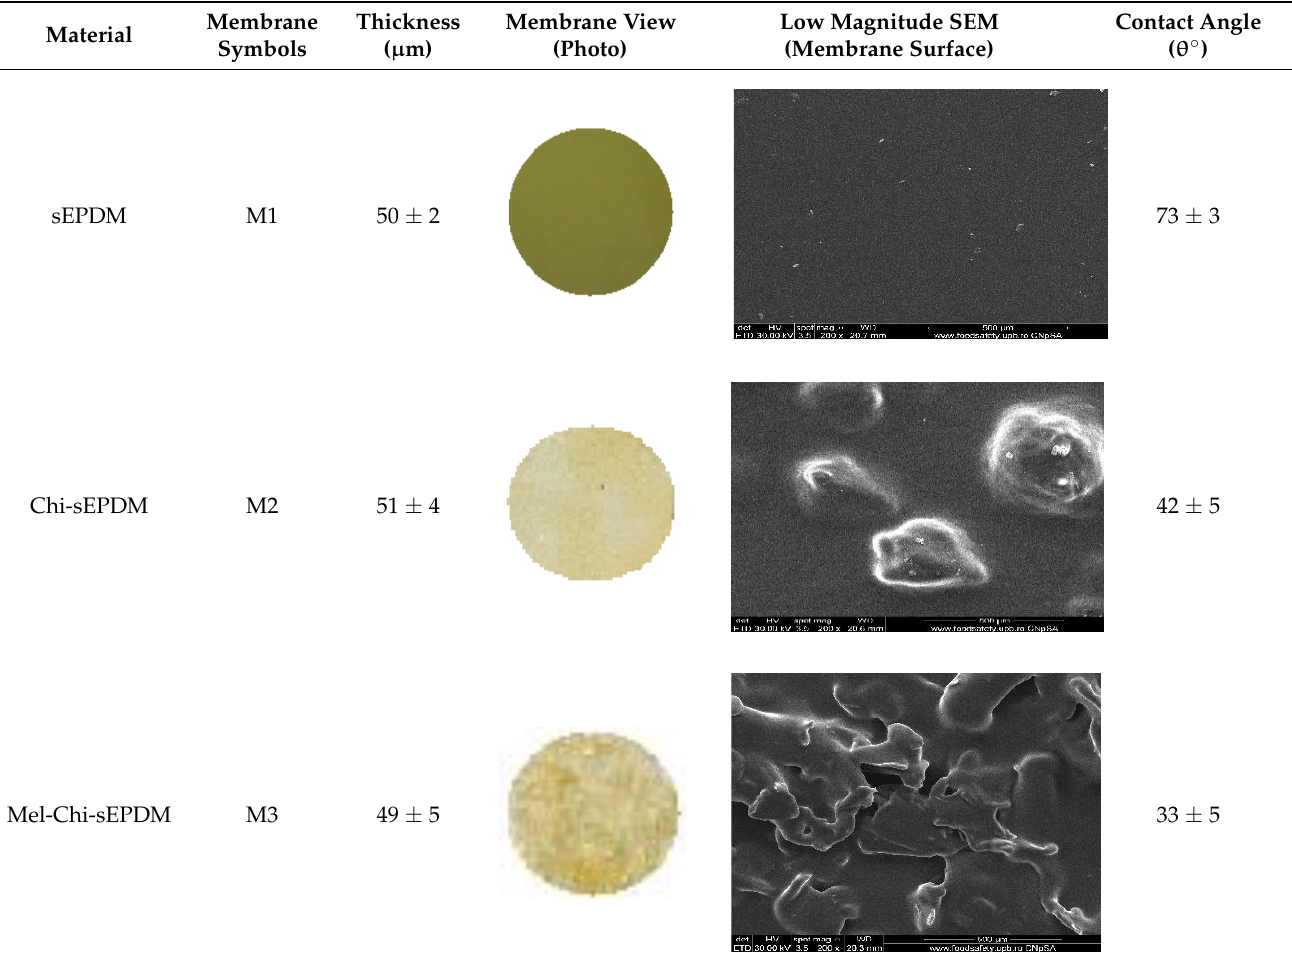
Table 2. The macroscopic characteristics for the obtained membranes.